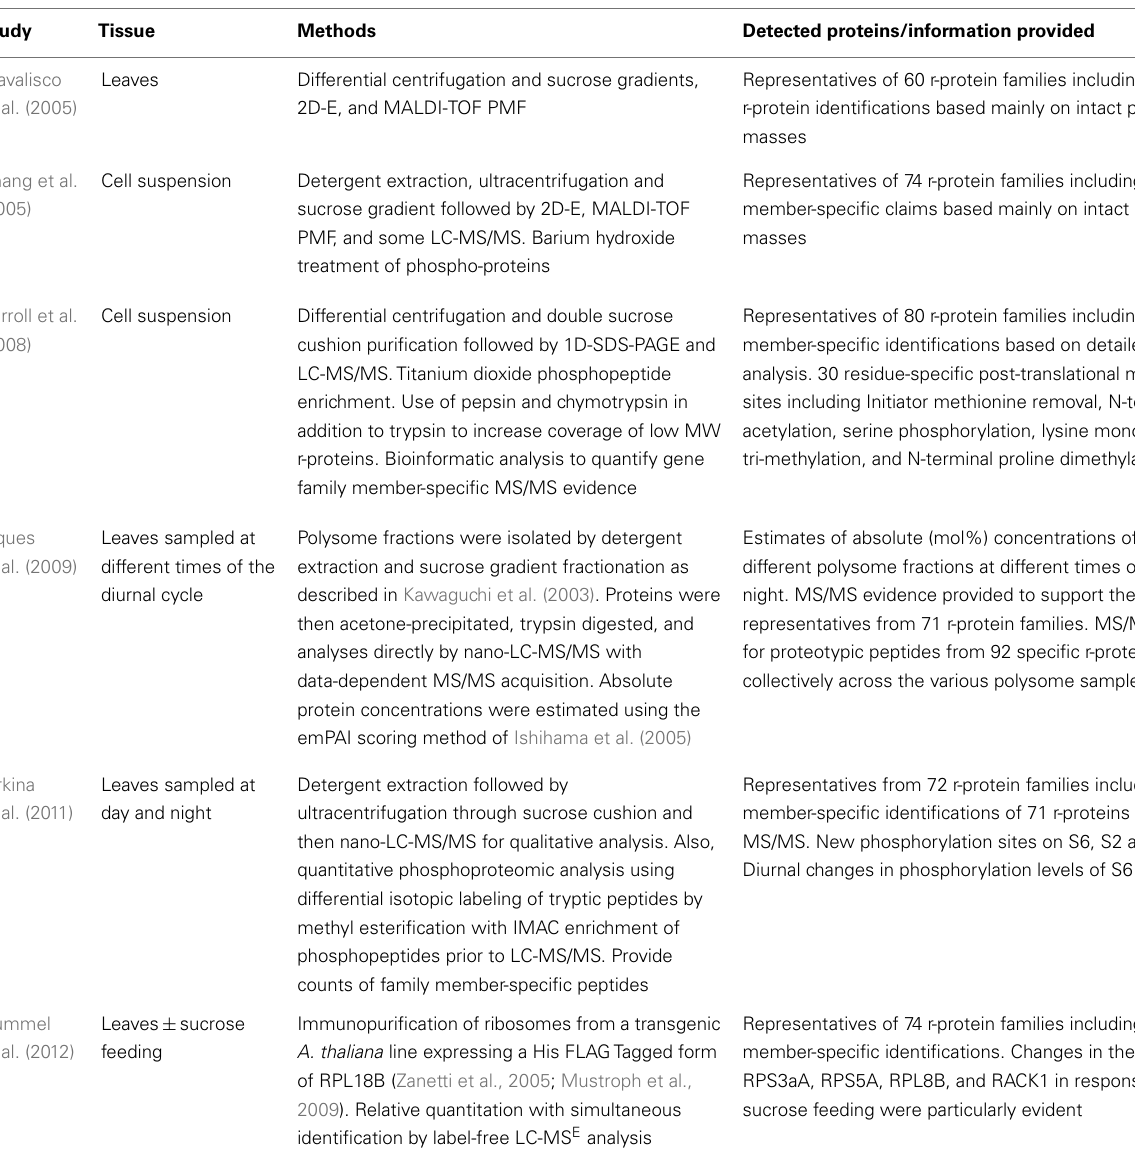
Table 1 | Proteomic studies of Arabidopsis thaliana ribosomes – an